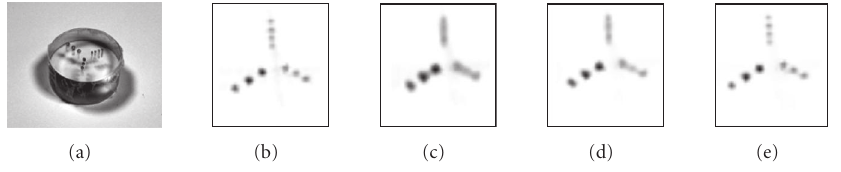
Figure 5: Photo of the phantom with 3 types of cavities (diameters 1mm, 1 . 5mm, and 2mm separated by the same distance) which can be filled with a radioactive tracer (a). Transaxial slices of the reconstructed phantom with 3 iterations of FA-SART and ρ = 1 (b), 3 iterations of SART (c), and 10 iterations of SART (d). Figure (a) shows significant improvements even when compared with 10 iterations of SART. Figure (e) shows the result obtained from an interesting combination of the two algorithms: 3 iterations of FA-SART ( ρ = 1) followed by 2 iterations of SART.